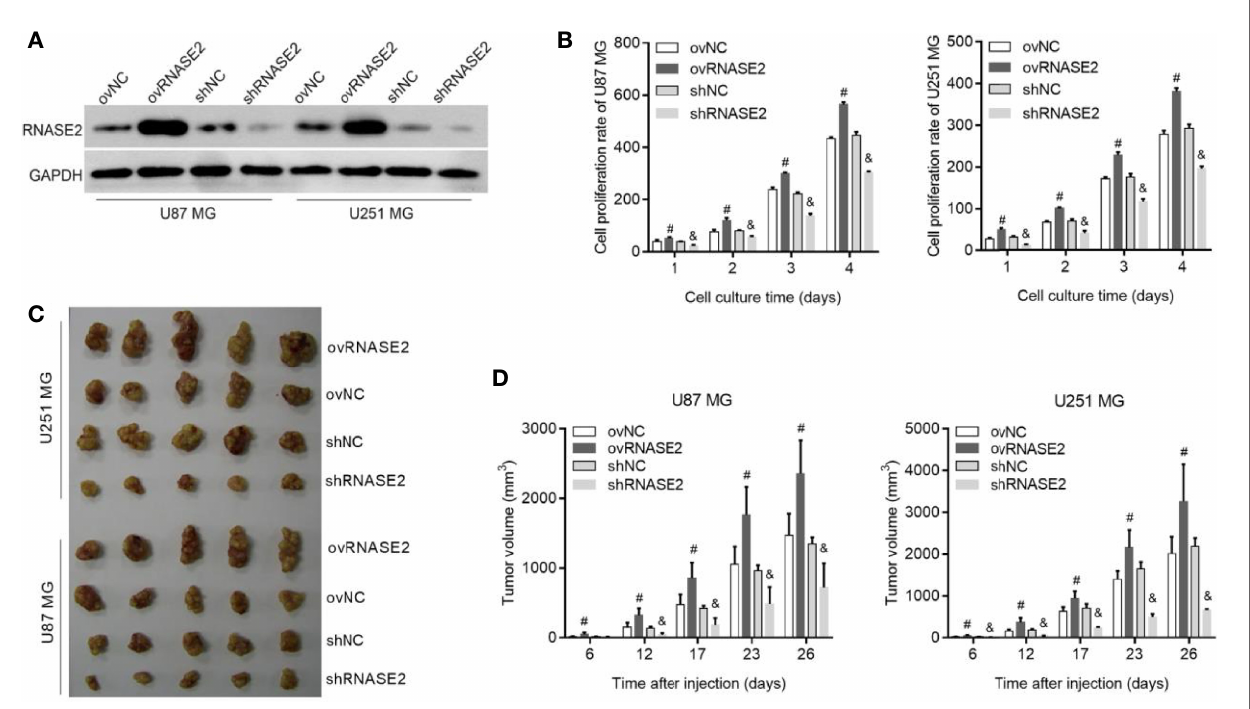
FIGURE 2 | RNASE2 overexpression promotes the proliferation of U87 MG and U251 MG cells, while RNASE2 knockdown suppresses it. RNASE2-overexpressing (ovRNASE2) and RNASE2-silenced (shRNASE2) cells were constructed. The ovNC and shNC groups were used as control cells. (A) Western blot showing successful RNASE2 protein overexpression and knock down. (B) Cell proliferation was promoted by RNASE2 overexpression and suppressed by RNASE2 knockdown after culture for 1, 2, 3, and 4 days. (C, D) The growth of subcutaneous tumors was promoted by RNASE2 overexpression and suppressed by RNASE2 knockdown. Panel (C) shows a photograph of the subcutaneous tumors. Panel (D) shows the statistical results of tumor volume after cell injection for 6, 12, 17, 23, and 26 days. # indicates p < 0.05; ovRNASE2 versus ovNC. & indicates p < 0.05; shRNASE2 versus shNC.